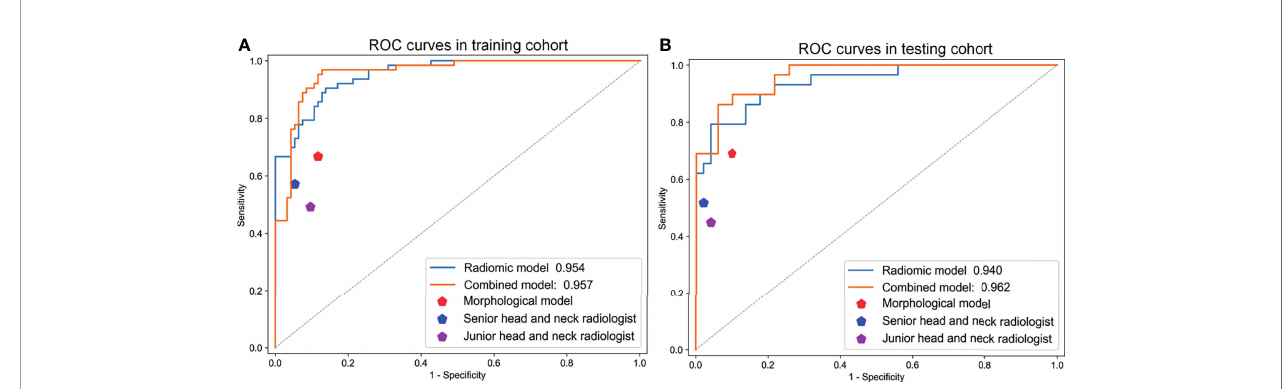
FIGURE 2 | The ROC curves of the radiomic model, morphological features model, and combined model in (A) training and (B) testing cohorts.